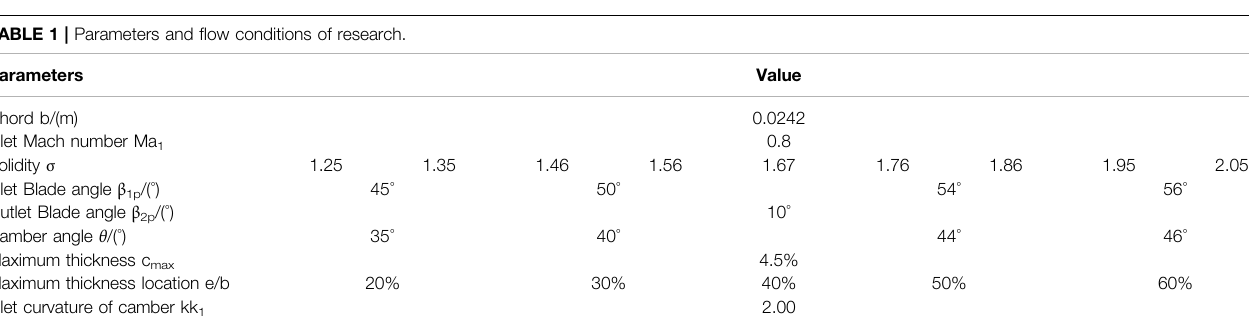
TABLE 1 | Parameters and fl ow conditions of